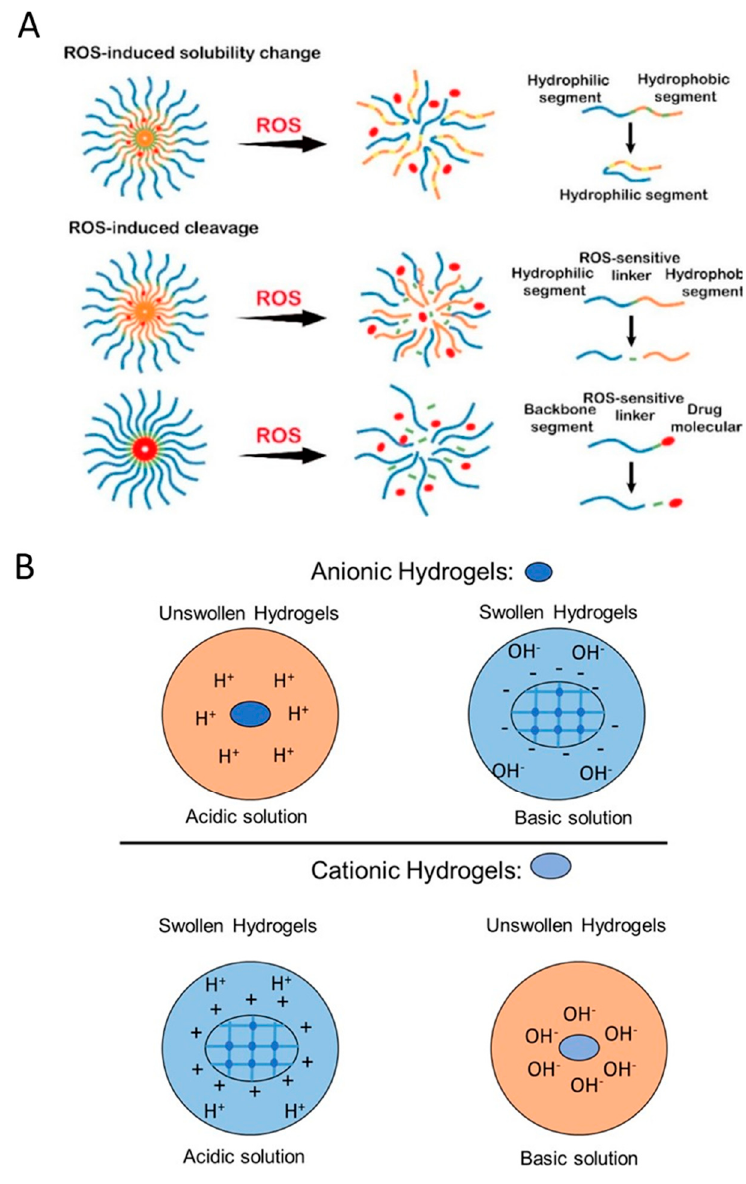
Figure 5. ( A ) Schematic of reactive oxygen species (ROS)-sensitive drug delivery mechanism including ROS-mediated solubility change and ROS-mediated cleavage of hydrogels. Adapted with permission from Tu et al. [108]. ( B ) Schematic of pH-responsive swelling of anionic and cationic hydrogels in acidic and basic solutions.